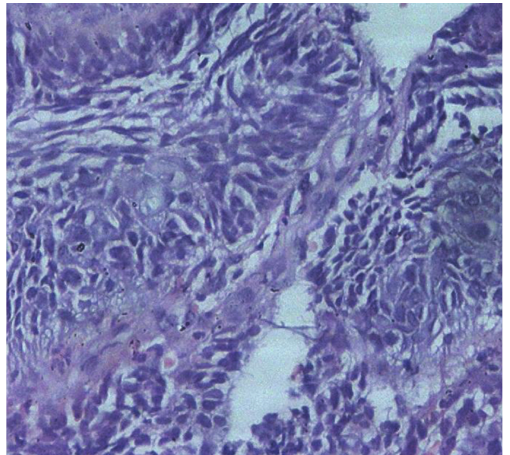
Figure 2: Photomicrograph showing sheets of small round cells with a scant amount of cytoplasm and hyperchromatic nuclei. (H&E; × 200.).